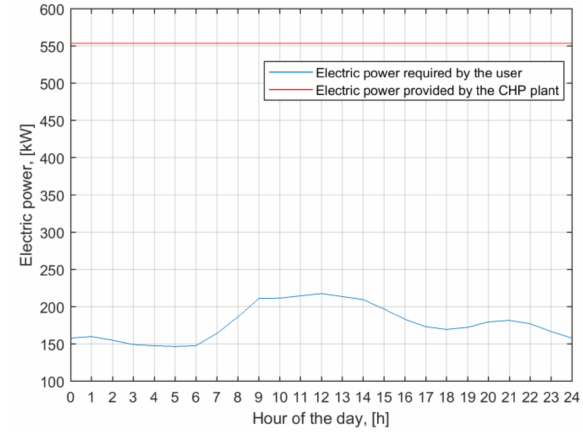
Figure 8. The electric power required by the user and that provided by the CHP plant.